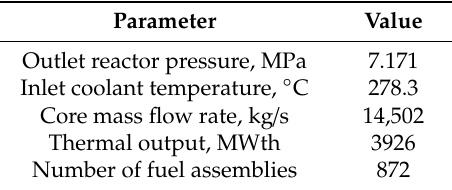
Table 3. Design parameters for ABWR reactor core [32].